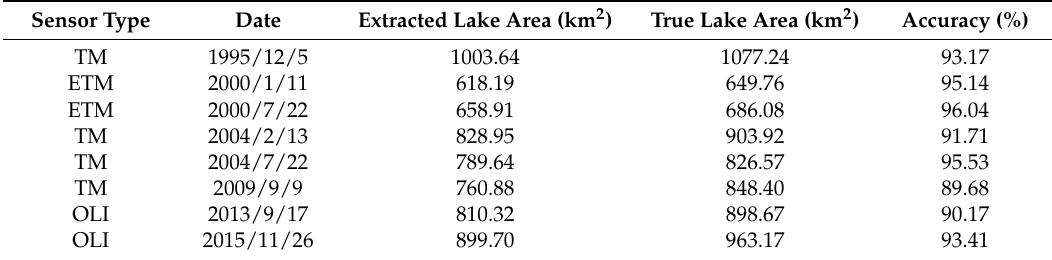
Table 3. Accuracy of extracted lakes based on the random forest model.